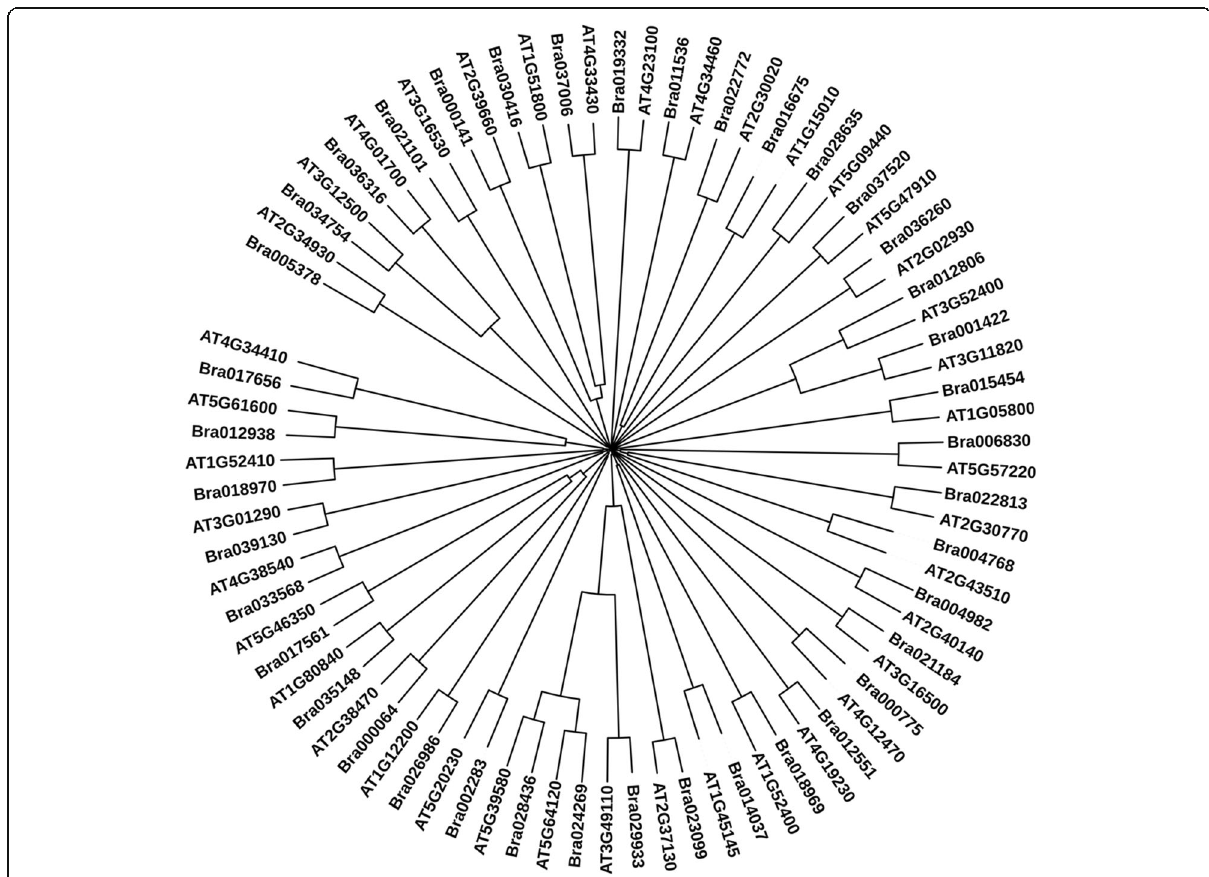
Fig. 5 Neighbor-Joining tree was constructed to determine the relationship among Arabidopsis and Brassica sequences involved in defense response against fungi extracted from contrast SAMC and